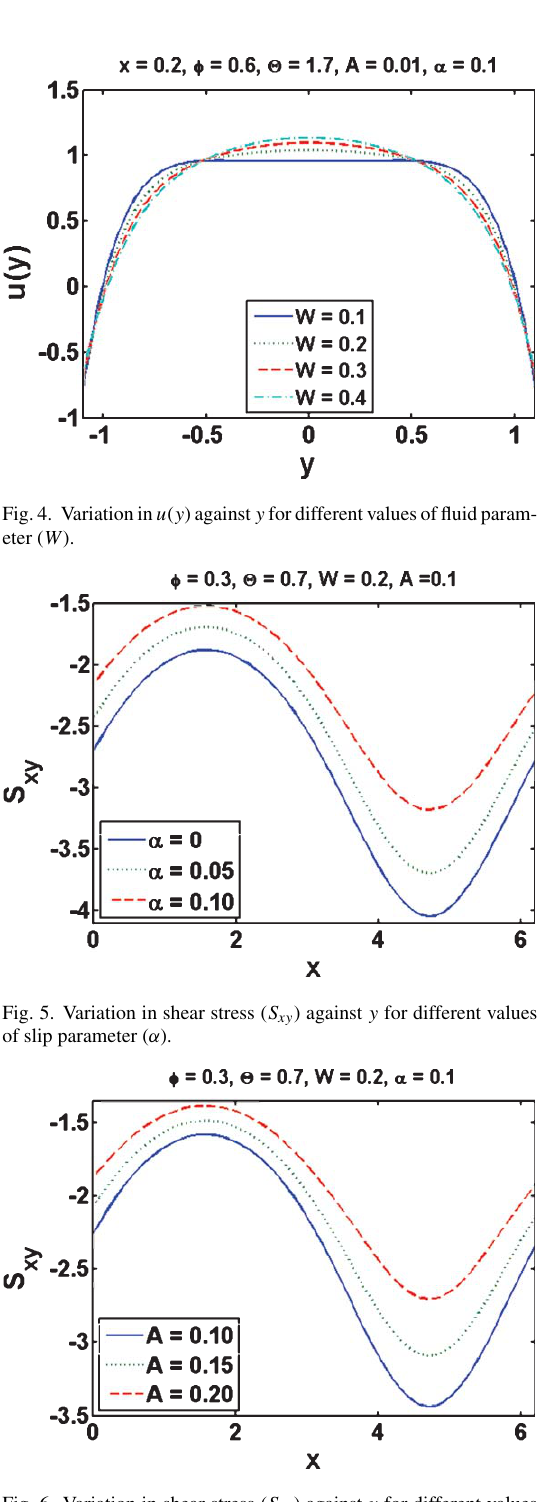
Fig. 6. Variation in shear stress ( S xy ) against y for different values of fluid parameter ( A ).